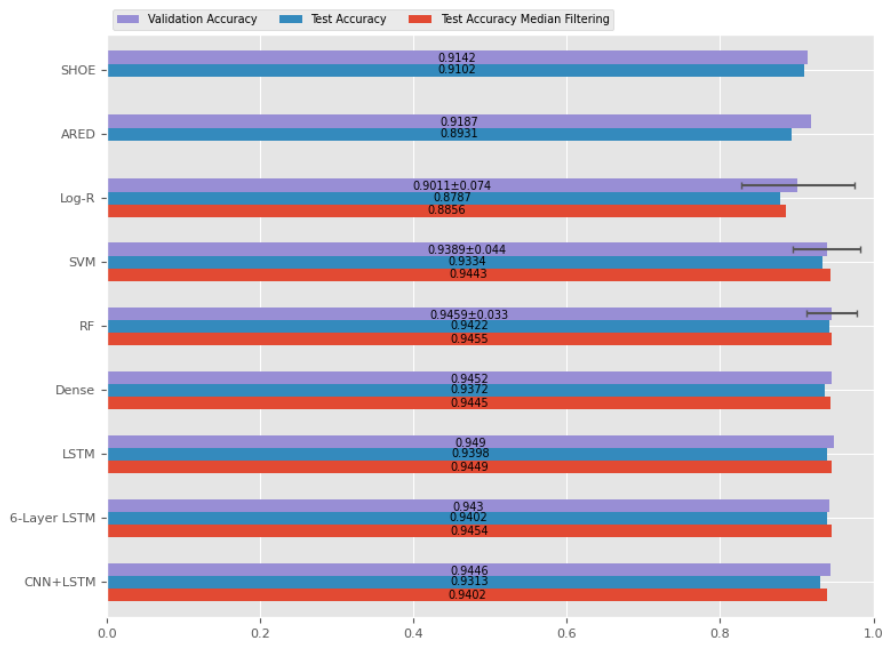
Figure 8. Accuracy of the different used classifiers (SHOE, Stance Hypothesis Optimal Estimation; ARED, Angular Rate Energy; Log-R, Logistic Regression; SVM, Support Vector Machine; RF, Random Forest; Dense, Densely Connected Neural Network; LSTM, Single Layer LSTM; CNN + LSTM, Convolutional Layers + LSTM